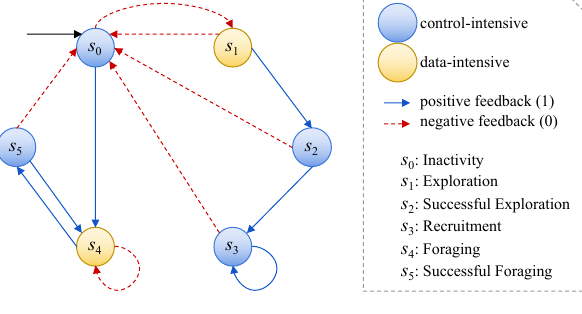
Figure 2. Proposed workflow to design the real-time video tracking system. ( a ) The automaton of Perez-Cham et al. [38] that formally describes the HSA meta-heuristic in an abstract non-architecture- specific manner. ( b ) System-level abstraction based on the HSA automaton that shows the division of tasks between PS and PL. The PS is in charge of control-intensive operations that are conducted by the HSA meta-heuristic (states s 0 , s 2 , s 3 and s 5 ), whereas the PL focuses on the acceleration of ZNCC via concurrency and parallel processing (states s 1 and s 4